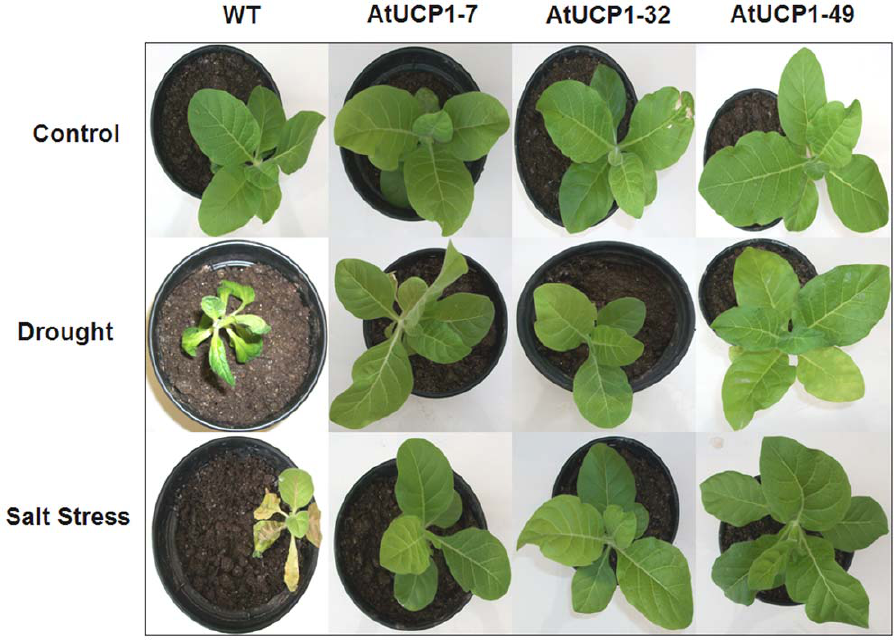
Figure 2. Phenotypes of wild-type (WT) and AtUCP1 transgenic tobacco plants under drought and salt stresses. First row: WT plants and three AtUCP1-overexpressing lines (7, 32 and 49) were grown under control conditions for 5 weeks. Middle row: plants watered with 200 mM mannitol for 10 days and then irrigated with water for 3 days. Bottom row: plants irrigated for 10 days with 175 mM NaCl and then irrigated with water for 3 days. A total of 5 plants from each line were used in the assay, and a representative plant is